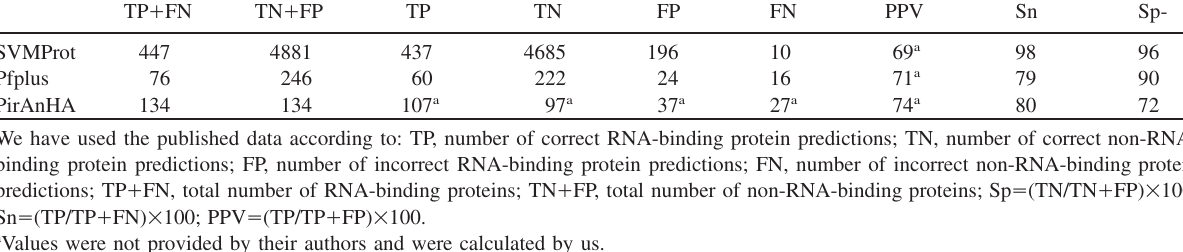
Table 3 Performance evaluation parameters of methods for identification of RNA-binding proteins. TP q FN